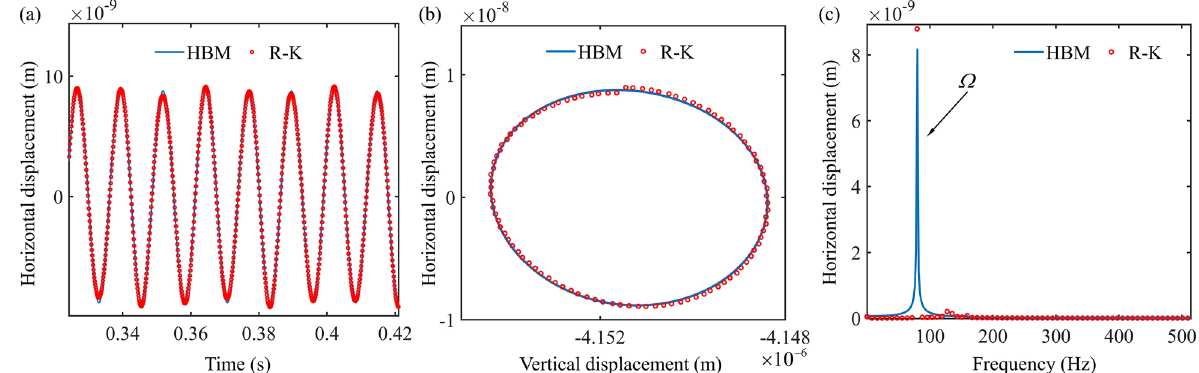
0.3, c p 10, and Ω 500 rad/s at node 10: ( a ) Time history, = = =